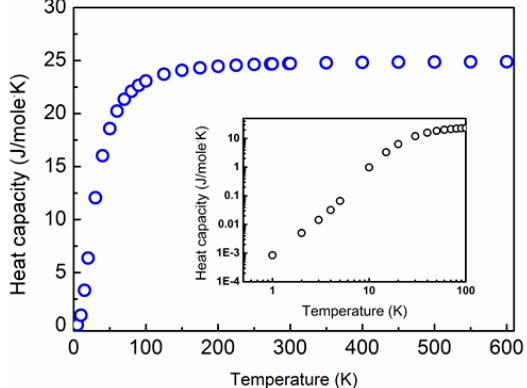
Figure 3. The temperature-dependent heat capacity, (cid:1829) (cid:3049) (cid:4666)(cid:1846)(cid:4667) , of PbTe as calculated from first